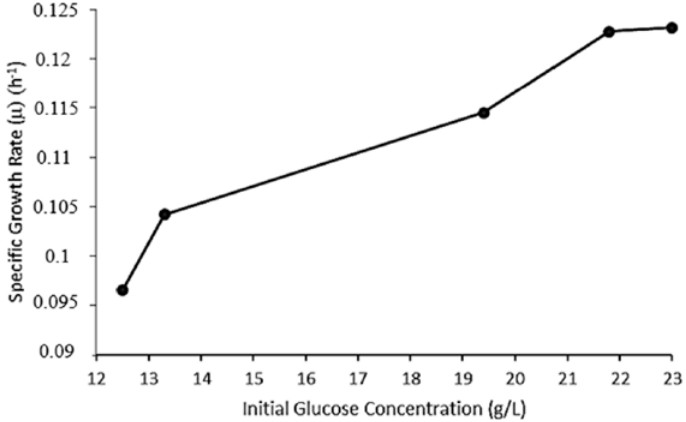
Figure 1. Specific growth rates ( µ ) of S. cerevisiae BY4743 at varied initial glucose concentrations.